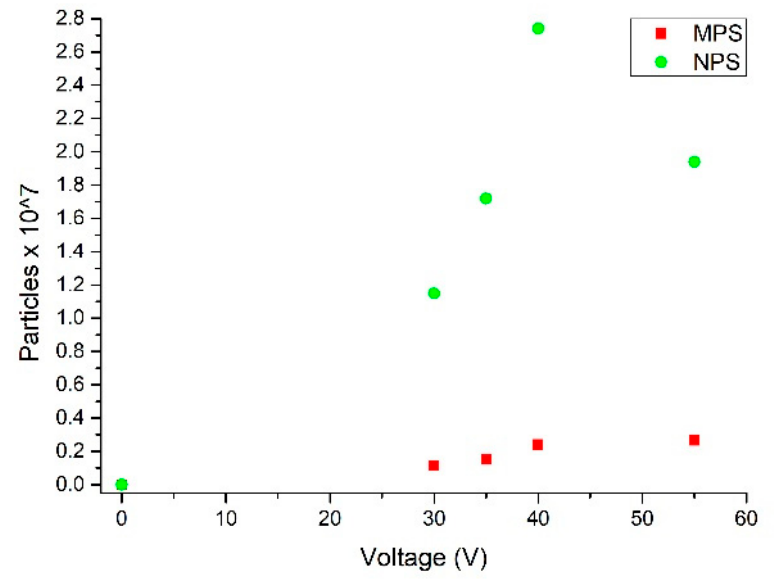
Figure 7. Number of M / NPs collected at outlet#1 when ∆ V = 0, 30, 35, 40, 55 V were applied at the electrodes.